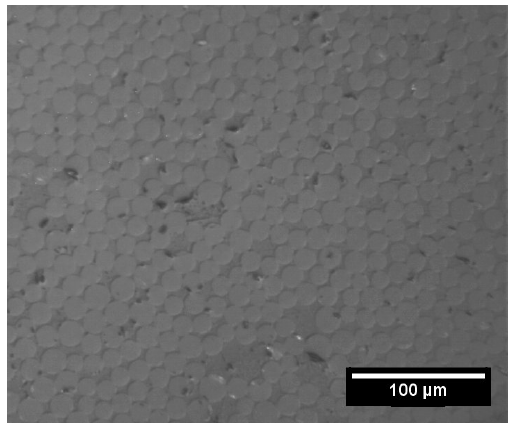
Figure 13. Microstructure image of sample A2 on its flat side surface, 200×. The ECR glass fibers in section and slightly darker epoxy resin are visible. Dark chipping of fiber fragments and less often of binder are few.